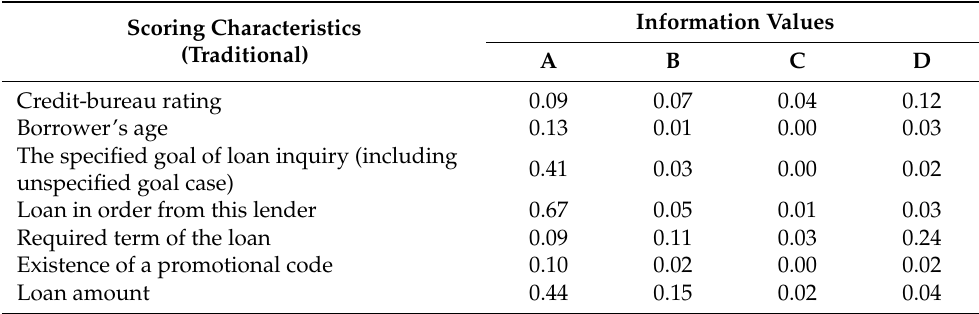
Table 3. Information values for traditional characteristics of scoring